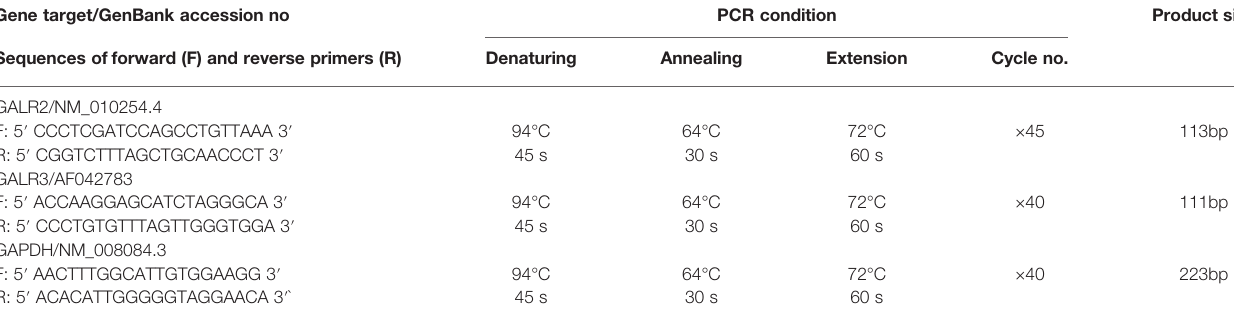
TABLE 2 | Primer sequences and PCR conditions for RT-PCR of mouse GALR2/3. Gene target/GenBank accession no PCR condition Product size Sequences of forward (F) and reverse primers